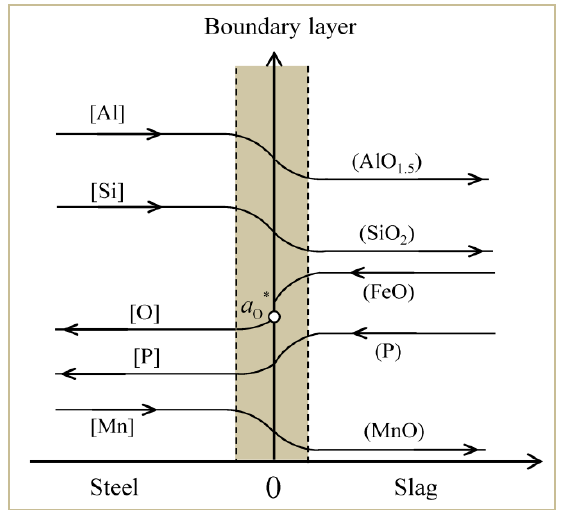
Figure 2. Schematic diagram of mass flux across the slag-metal interface.